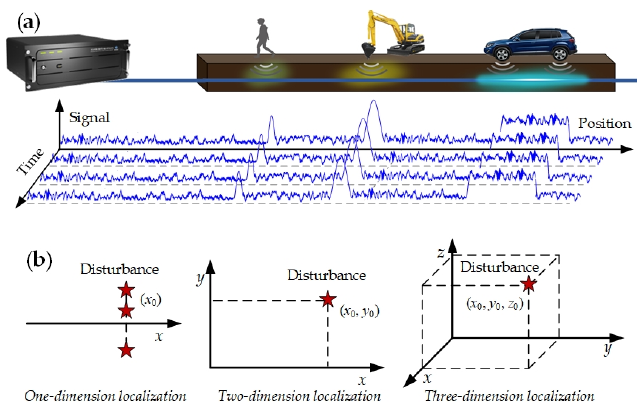
Figure 15. ( a ) Concept diagram of detection signals along the sensing fiber. ( b ) Concept diagram of multi-dimension localization. multi-dimension